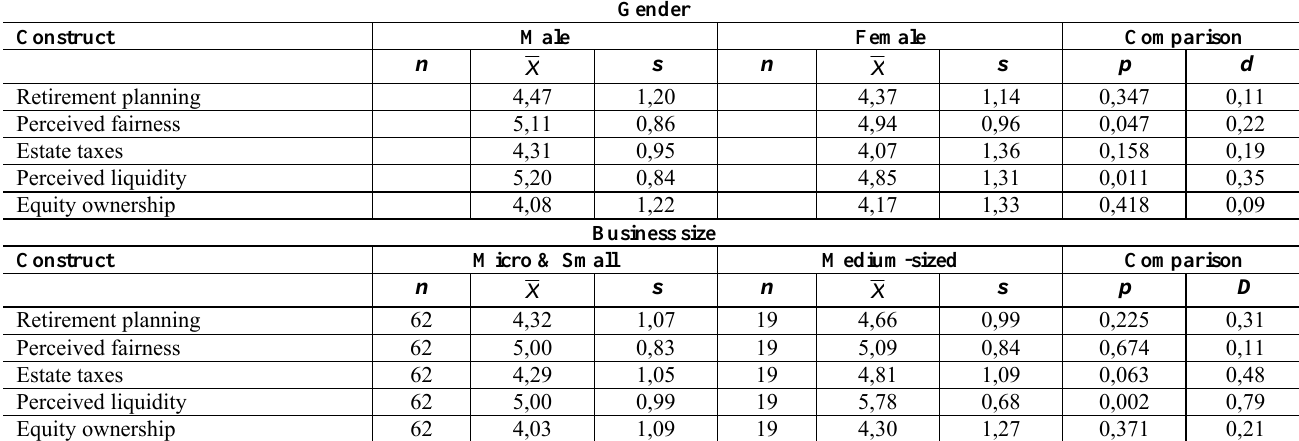
Table 3: Results of the differences in means between the constructs for the demographic variables gender and business size Gender Construct